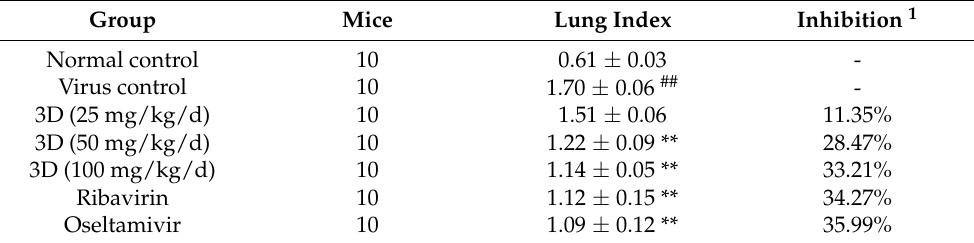
Table 3. The inhibitory effect of 3D on lung index at sic days post infection. Group Mice Lung Index Inhibition